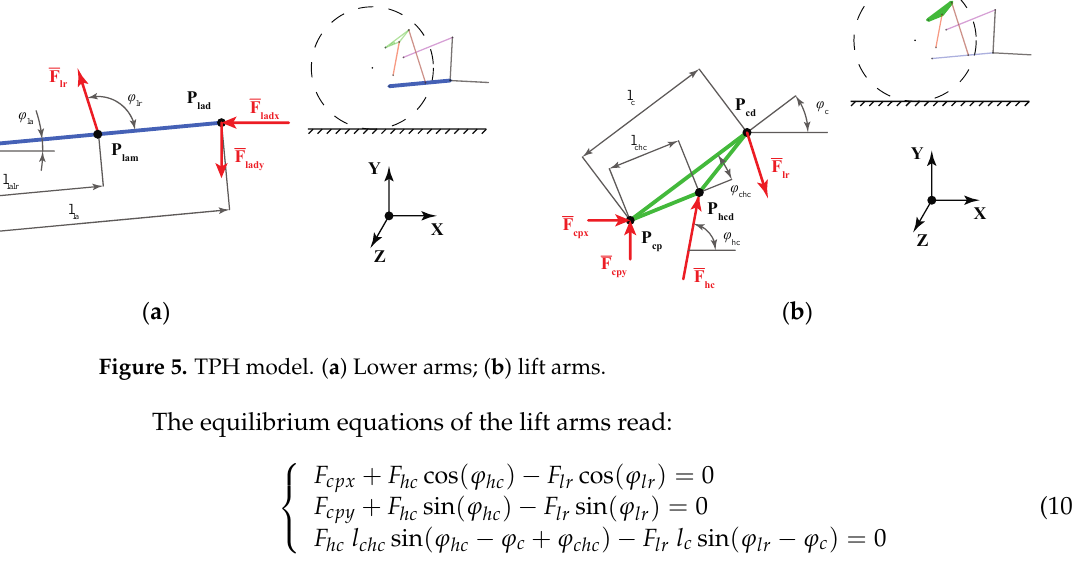
Figure 6. ( a ) The tractor model with the external loads acting on it; ( b ) displacement of the points 𝑃 𝑡𝑓 and 𝑃 𝑡𝑟 due to the sole pitch motion of the tractor.